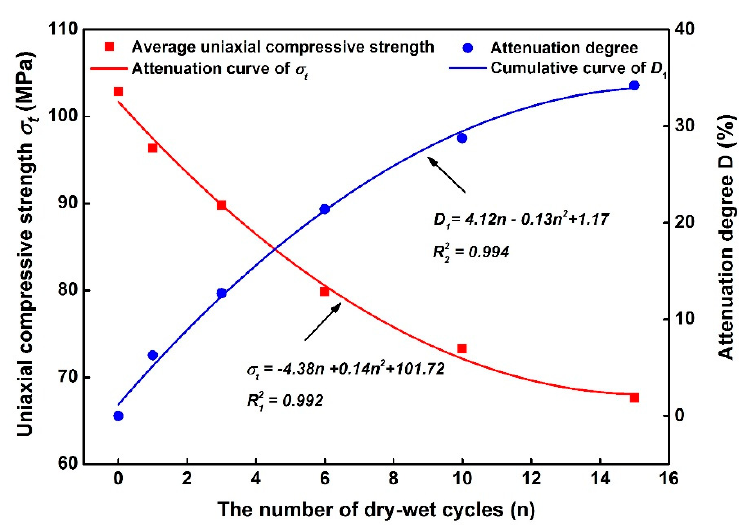
Figure 6. The changes of average uniaxial compressive strength of rock and its degree of attenuation with the number of dry-wet cycles.